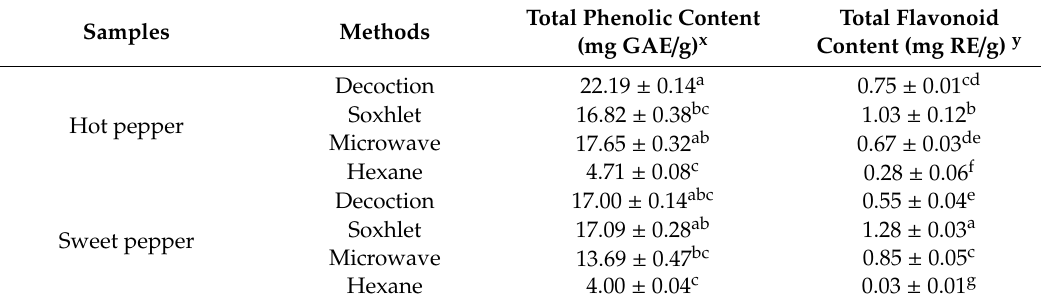
Table 1. Total phenolic and flavonoid contents in the tested extracts *